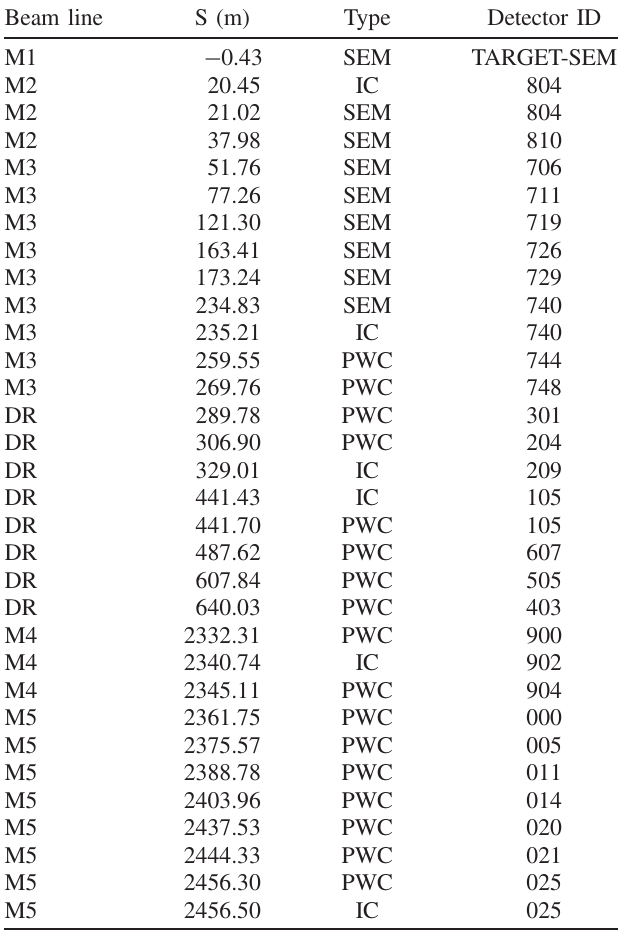
TABLE II. Location of available beam diagnostics along the Muon Campus. For the DR diagnostics, only their location during the first pass is shown. During operations for the Muon g − 2 experiment, the beam is circulating the DR four times. Note that S ¼ 0 is at the downstream edge of the